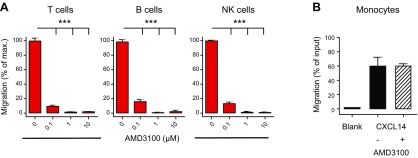
Synergy between CXCL14 and CXCL12 is completely abolished by blockade of CXCR4. PBMCs were pretreated with 0–10 μM AMD3100 before use in chemotaxis assays, as described above. A) Migration of T, B, and NK cells in response to the combination of 1 nM CXCL12 plus 300 nM CXCL14 is shown. Migration of each cell type in the absence of AMD3100 treatment (0 µM) is given as 100%. Data are means + sem of 4 blood donors across 2 independent experiments. ***P < 0.001 compared with no AMD3100 treatment, using a 1-way ANOVA plus Bonferroni posttest. B) Migration of monocytes toward 1 µM CXCL14 following either no treatment (−) or pretreatment with 10 µM AMD3100 (+). Migration is given as percent of total input monocytes.